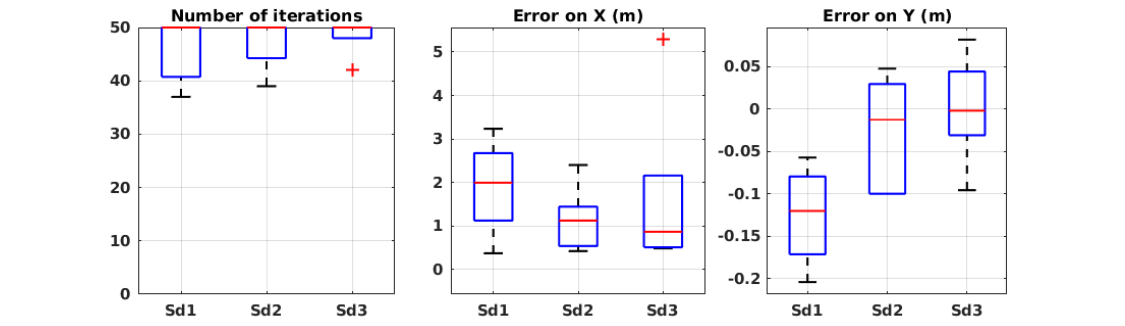
Figure 9. Evaluation results in wind tunnel experiments with different values of σ D . See Table 3 for the meaning of the labels.